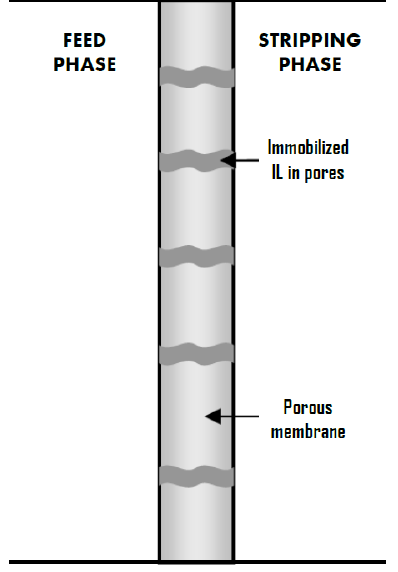
Figure 1. Schematic representation of a SILM (Supported Ionic Liquid Membrane).